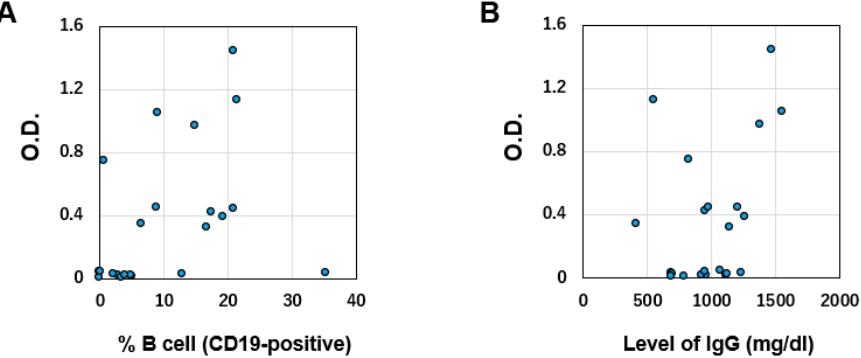
Figure 2. ( A ) Correlation between S1 antibody titer and percentage of CD19-positive B cells (normal range 6–23%). ( B ) Correlation between S1 antibody titer and total IgG level (normal range 870–1700 mg/dL). O.D.: Optical